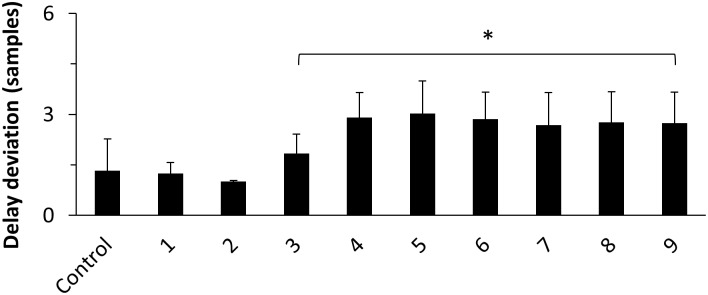
Delay deviation in samples for the Kus-model and increasing low-pass filter orders.Asterisks indicate results significantly different from control (Wilcoxon rank-sum test, p < = 0.05, Bonferroni corrected). Error bars indicate standard deviation.